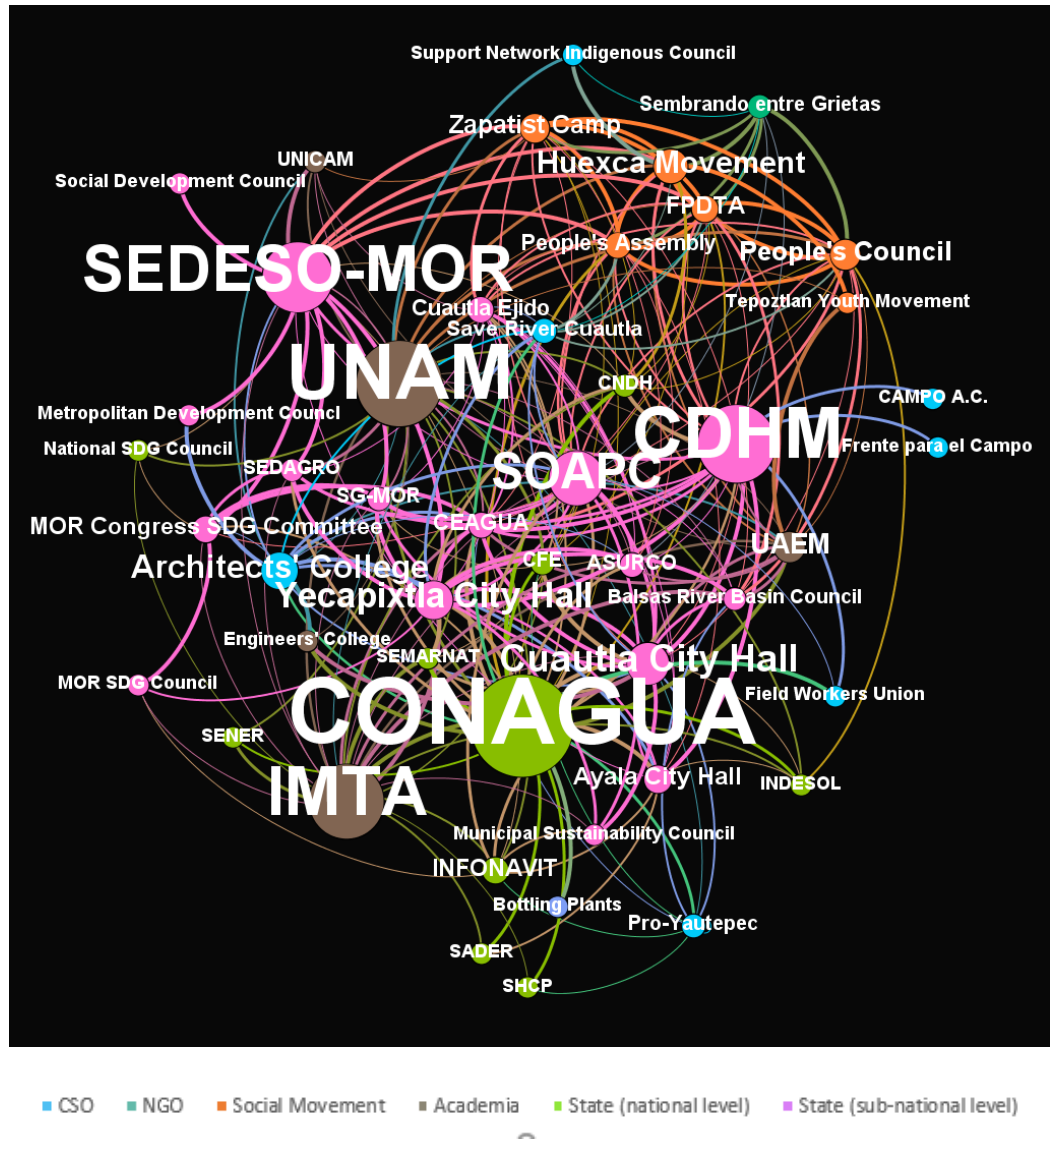
Figure 4. Network of communication between Water-, Energy-, Food (WEF)-Nexus actors. Table 5. WEF-Nexus actors in the research region ranked by influenced (based on betweenness and degree centrality values).